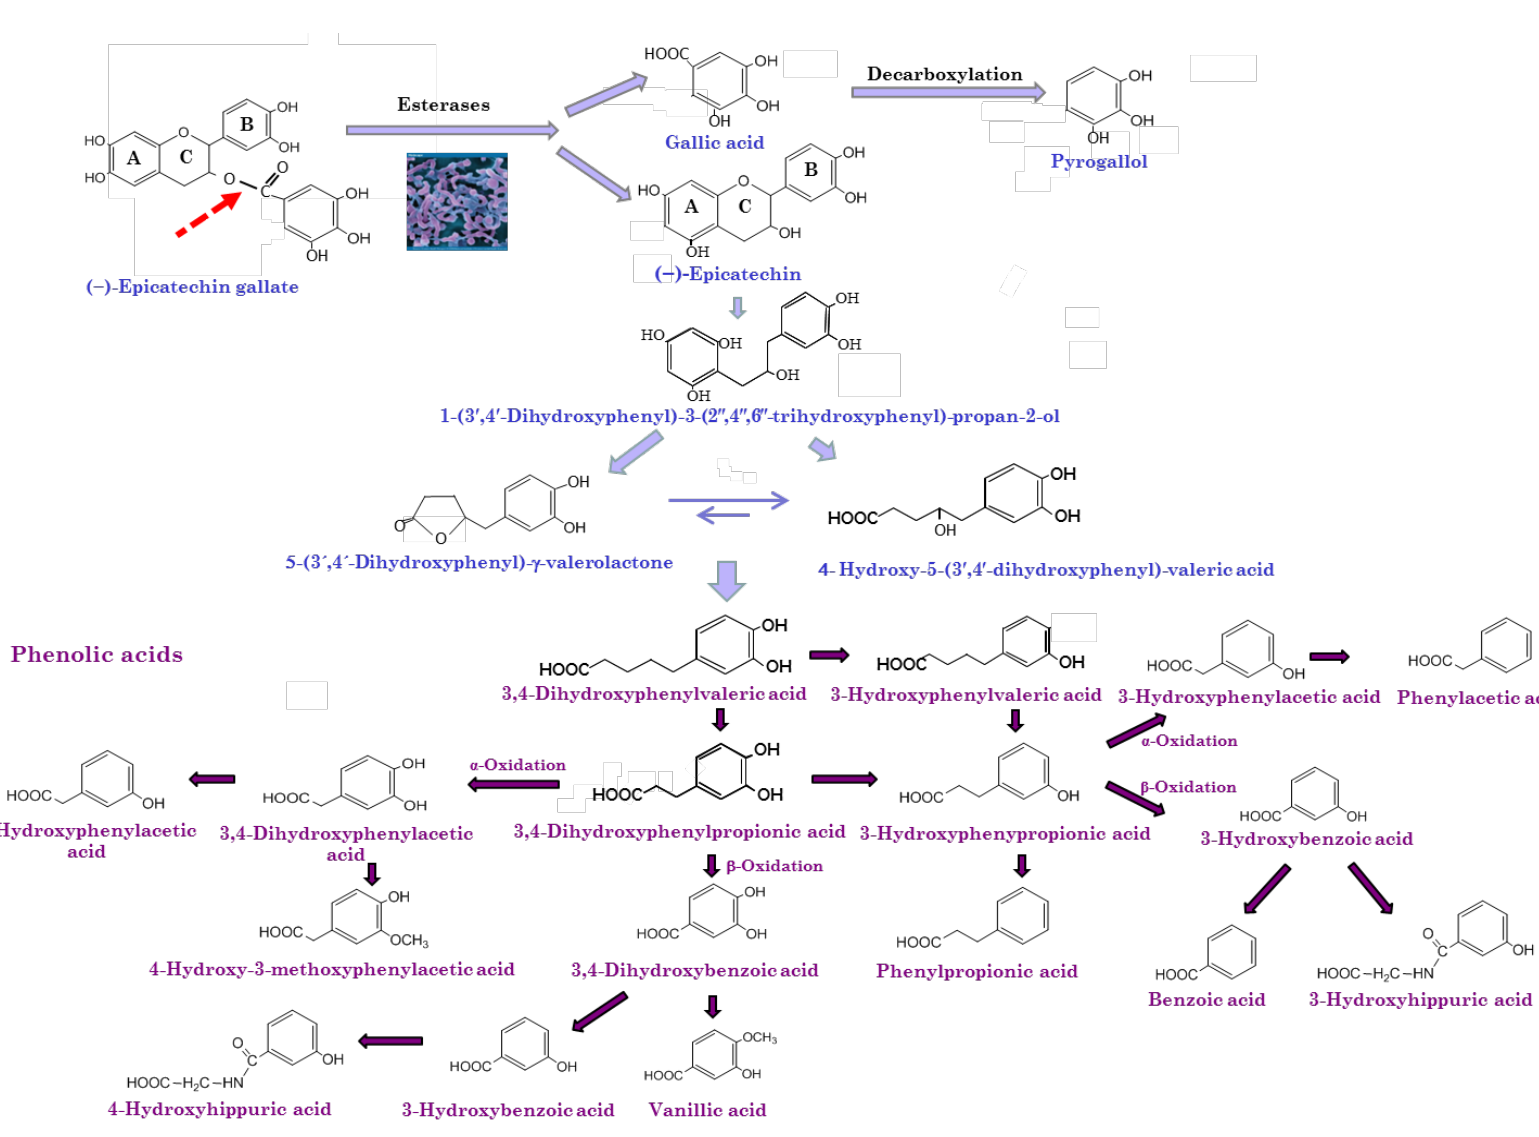
Figure 3. Catabolism of monomeric flavan-3-ols by gut